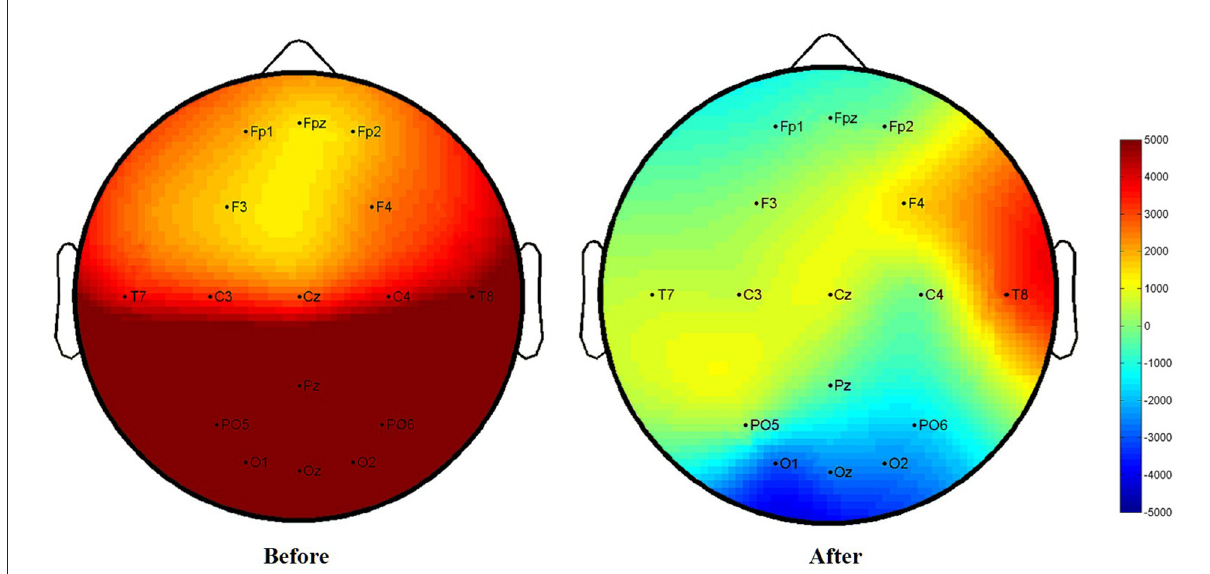
FIGURE8 Before and after treatment of the active acupuncture group (SSVEP).